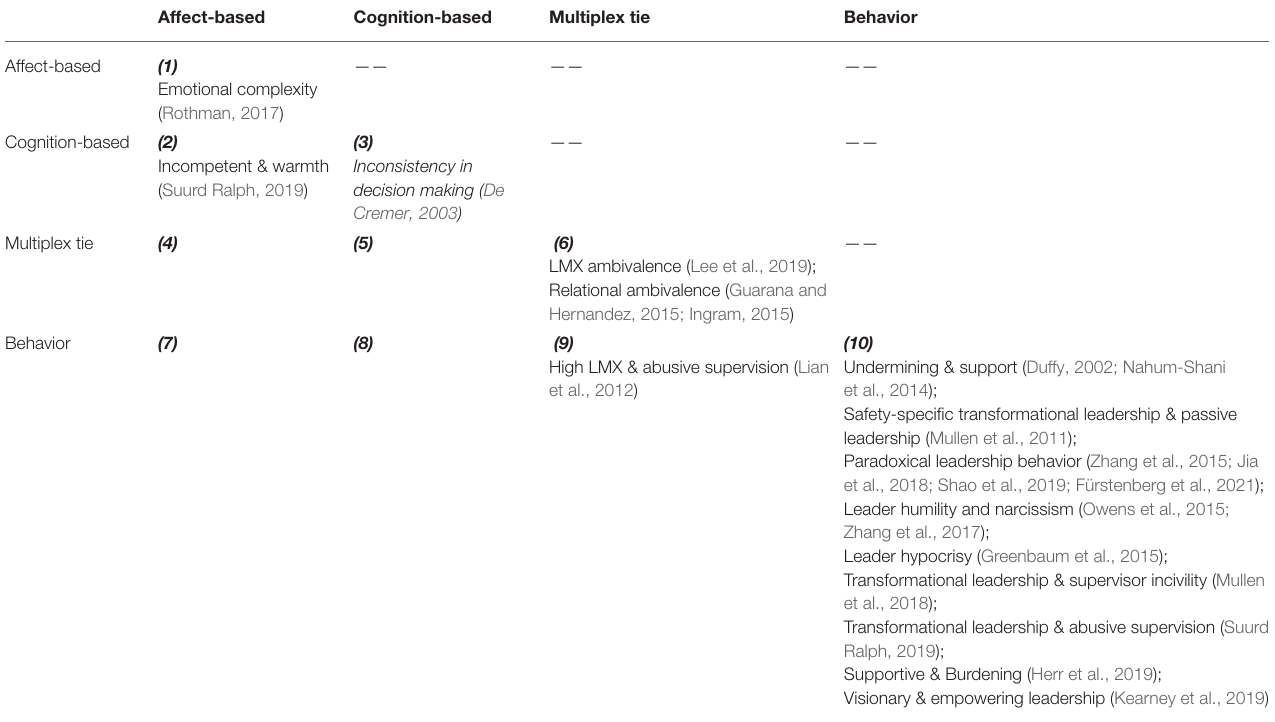
TABLE 2 | Ten types of ambivalent leader-follower relationships.